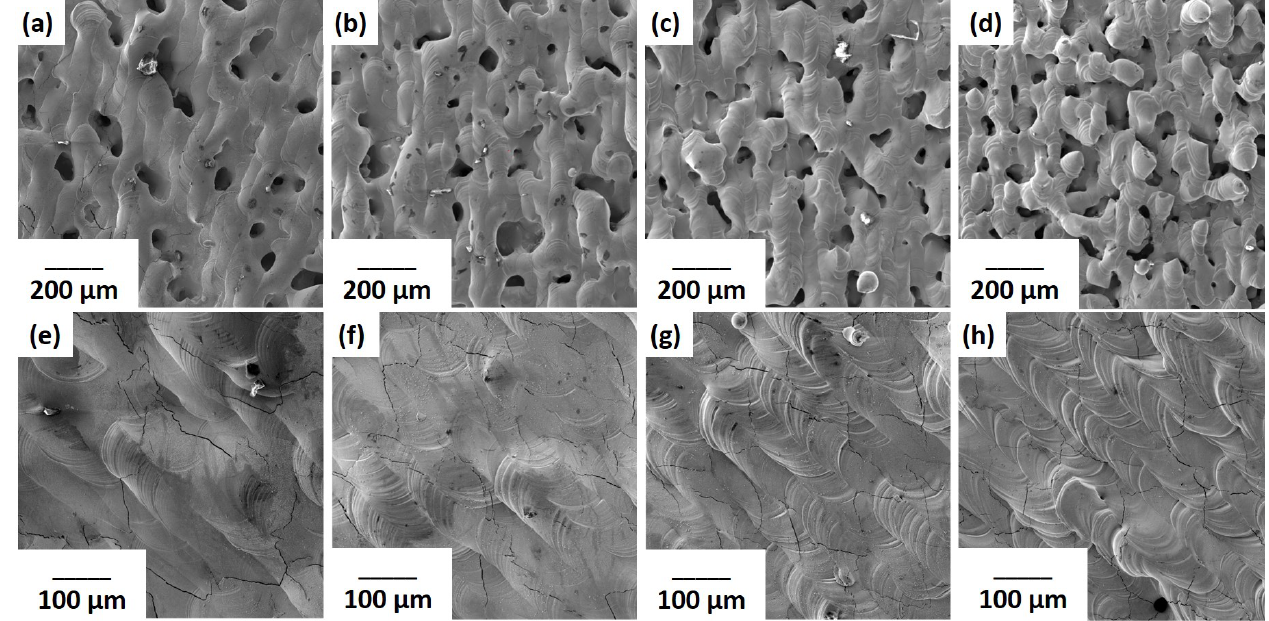
Figure 2. SEM images of the top surfaces of both materials at all four scan speeds: ( a – d ) Pure molybdenum printed at 100, 200, 400, and 800 mm/s, respectively; ( e – h ) Mo-0.1SiC printed at 100, 200, 400, and 800 mm/s,